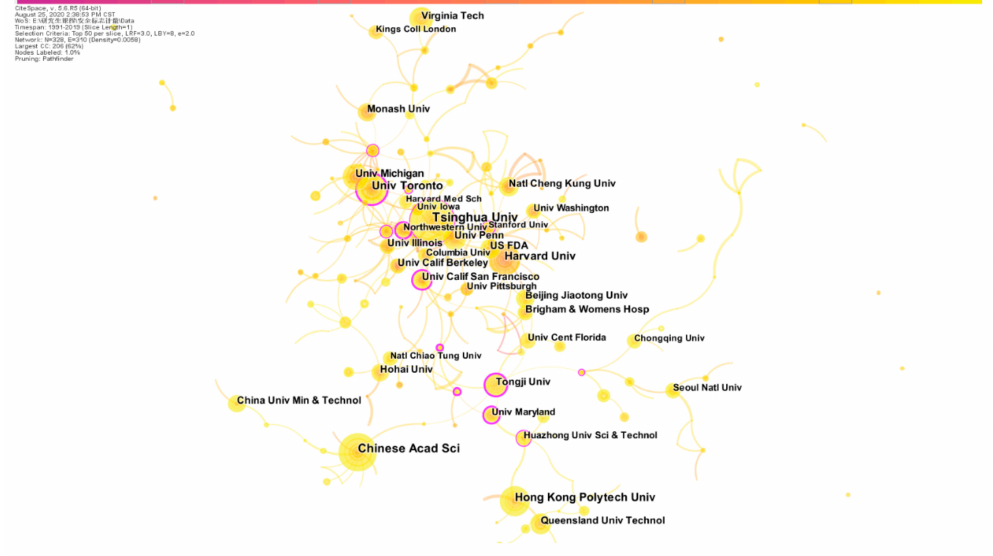
Figure 3. Institutions of safety signs research